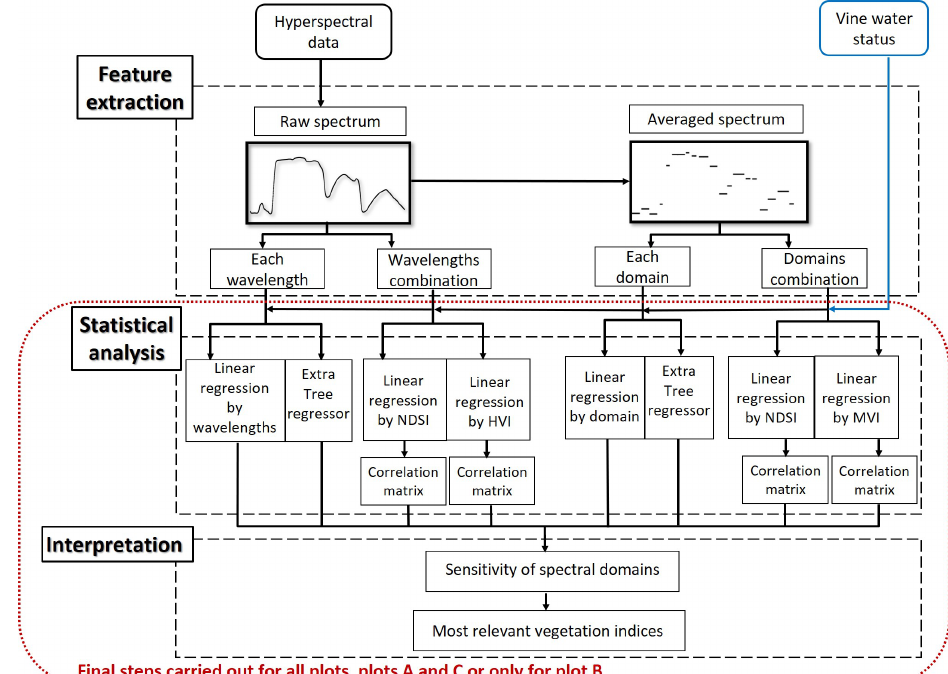
Figure 10. Flowchart of the method applied to identify the best domains related to vine water status using raw and average spectrum by domain. NDSI—Normalized difference spectral indices; HVI—Hyperspectral vegetation indices; MVI—Multispectral vegetation